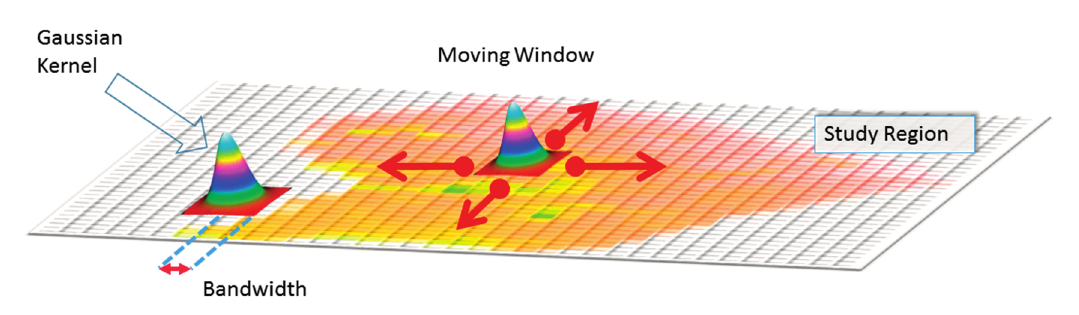
Figure 3. Geographically Weighted Regression scheme. Geographical weighting is achieved by a fixed Gaussian kernel function with a given bandwidth moving across the spatial domain. Bandwidth determines the rate at which the weights decay around each cell, and reflects the degree of spatial variation: if the bandwidth gets larger, the model will tend to a global regression